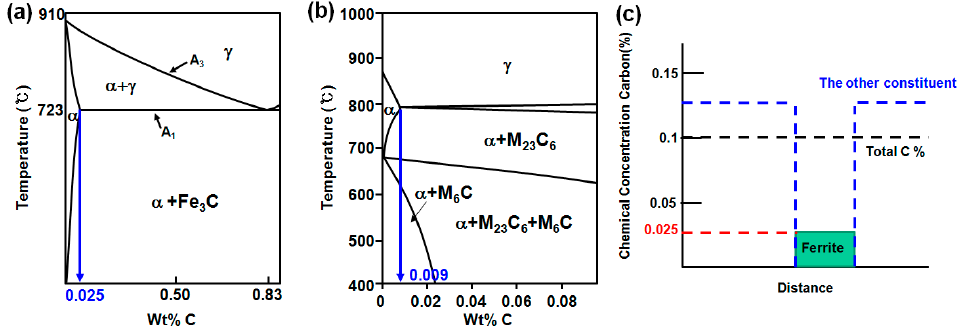
Figure 13. Schematic of calculation of carbon contents in the other constituent ( a ) Fe-C phase diagram ( b ) 2.25Cr-1Mo Steel + C phase diagram calculated using Thermo-calc ( c ) modeling of carbon concentration between ferrite and the other constituent.